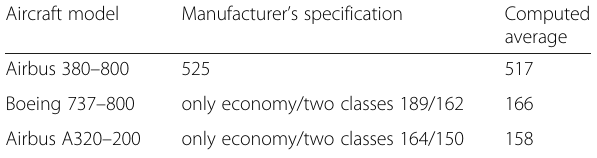
Table 4 Where there is no available data on seating configuration for a specific aircraft, the average for that model across all of the airlines is